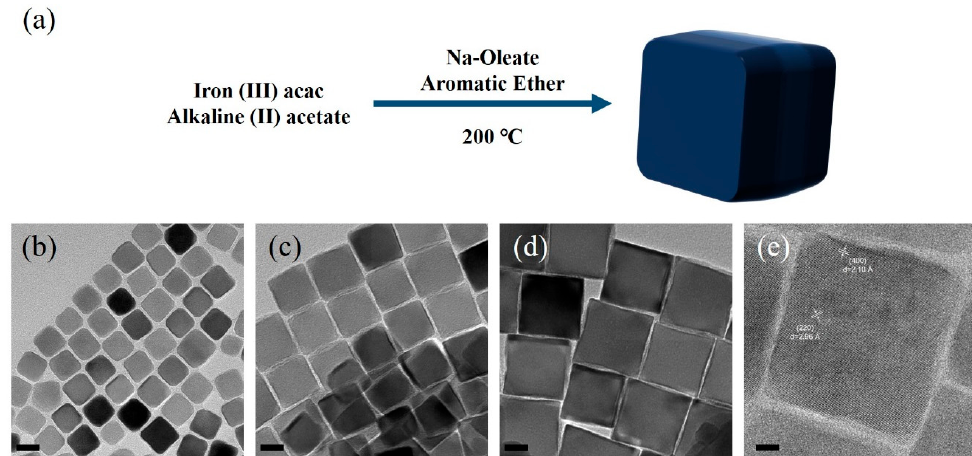
Figure 4. Scheme of Iron oxide nanocubes synthesis and TEM characterization. ( a ) Schematic of a synthetic method for magnetite nanocubes; ( b – d ) large area transmission electron microscopy (TEM) images of monodisperse magnetite nanocubes with alkaline metal ions assistance with the size distribution of 22 ± 1.2 nm, 36 ± 2.5 nm, 57 ± 5.1 nm in edge length with less 10% deviation. Scale bar is 20 nm ( d ) high-resolution TEM image for structural characterization. Scale bar is 5